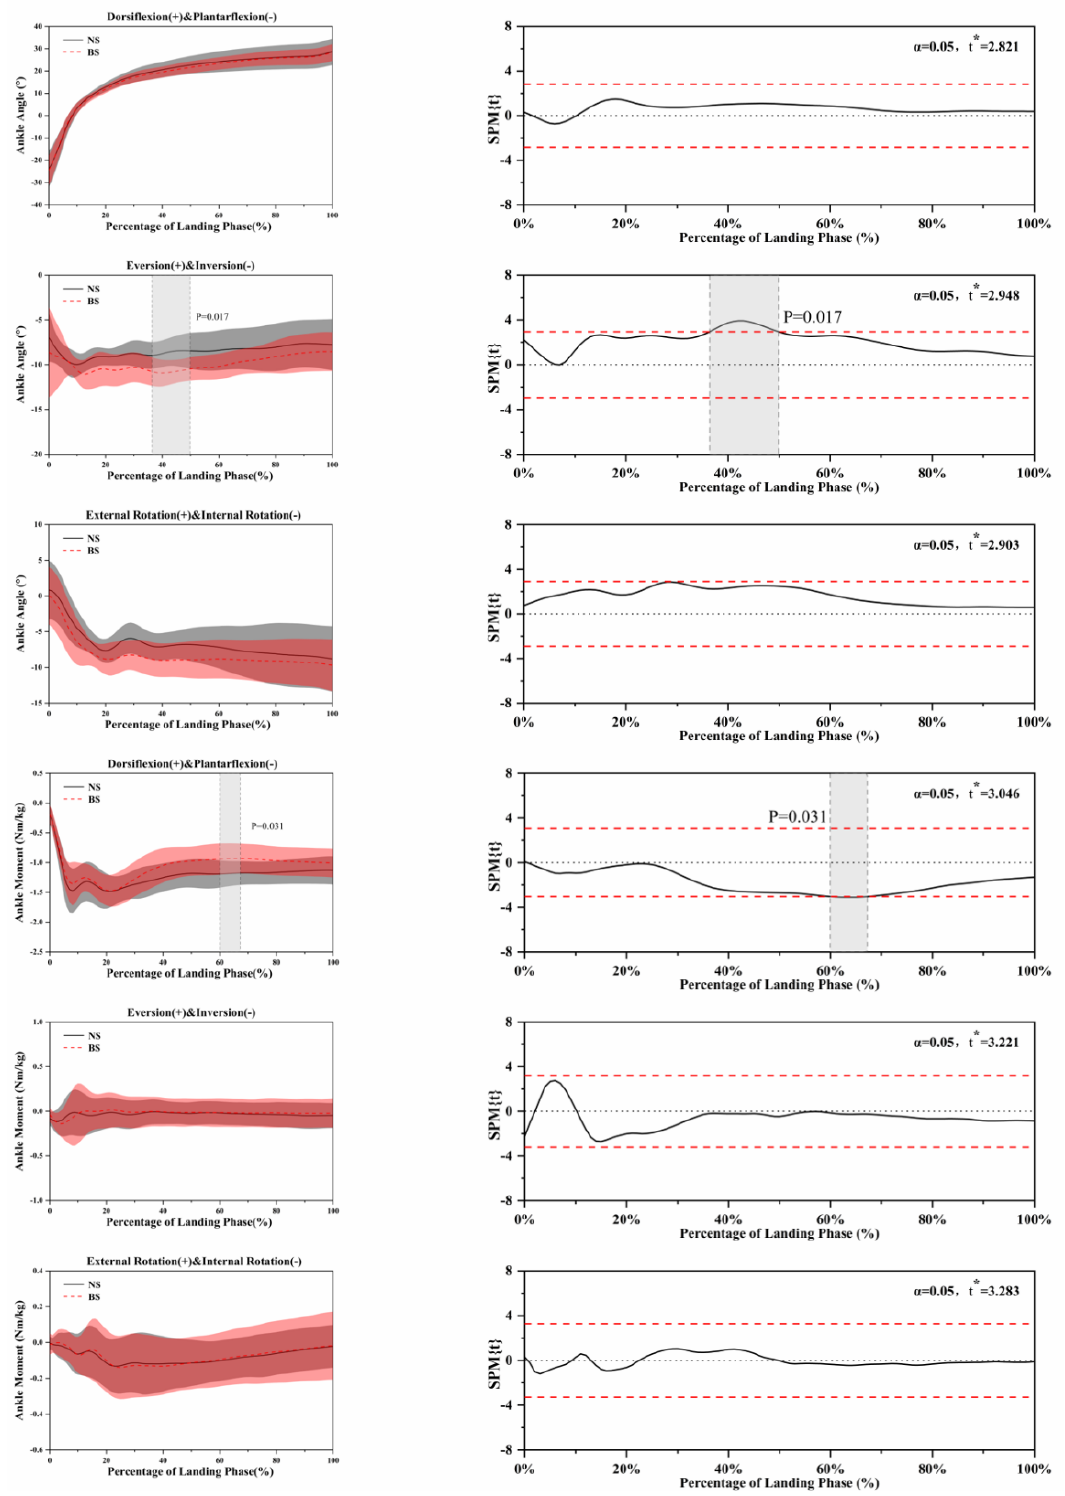
Figure 4. Descriptive results between NS and BS lower-limb statistical parametric mapping results for ankle angles and moments during the SLL phase, t -values of the SPM for all participants (post hoc results; dashed red lines represent p = 0.05 level). Grey shaded areas display regions that have statistically significant differences. The scale on the left of each image shows the change in the joint angle and the value of t *. The scale of 0–100 below each image presents an SLL phase.